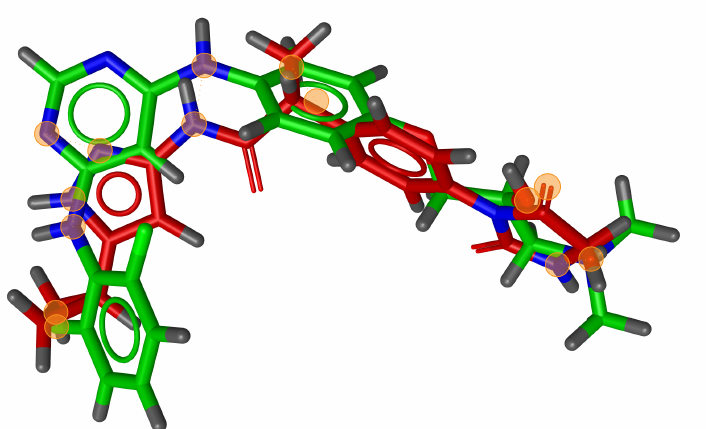
Figure 9. Example of G3PS alignment with seven matching feature pairs where RMM failed due to not finding three pairs. Orange circles = centre of matched